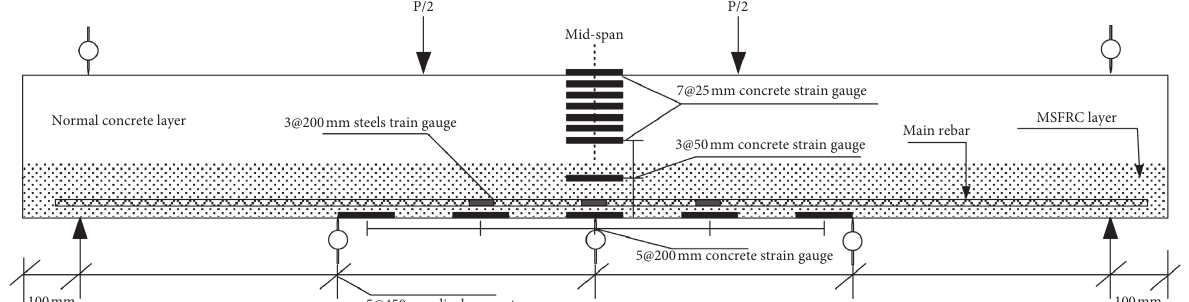
Figure 12: Arrangement of gauges for the RC beam partially reinforced by MSFRC.